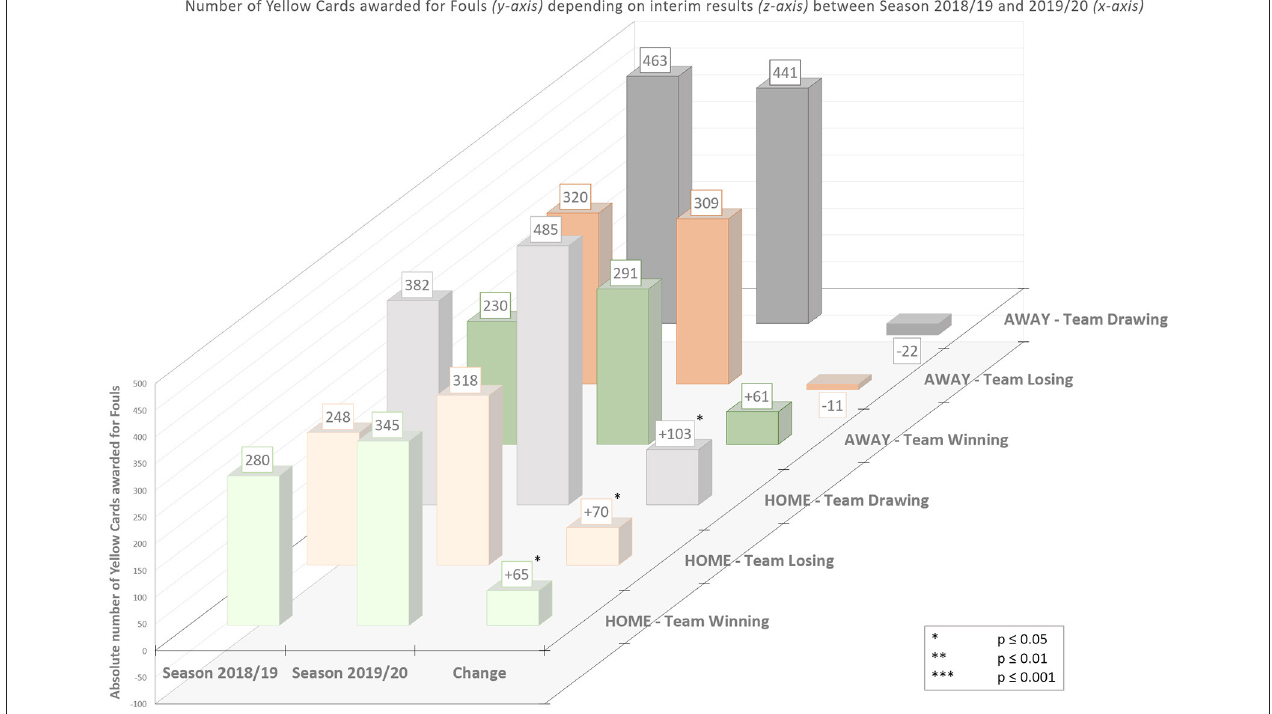
FIGURE 5 | Absolute differences in yellow cards for foul play depending on the course of the game. Absolute differences of yellow cards of home and away teams while winning, losing, or drawing in respective games of season 2018/19 (regular attendance) and season 2019/20 (limited